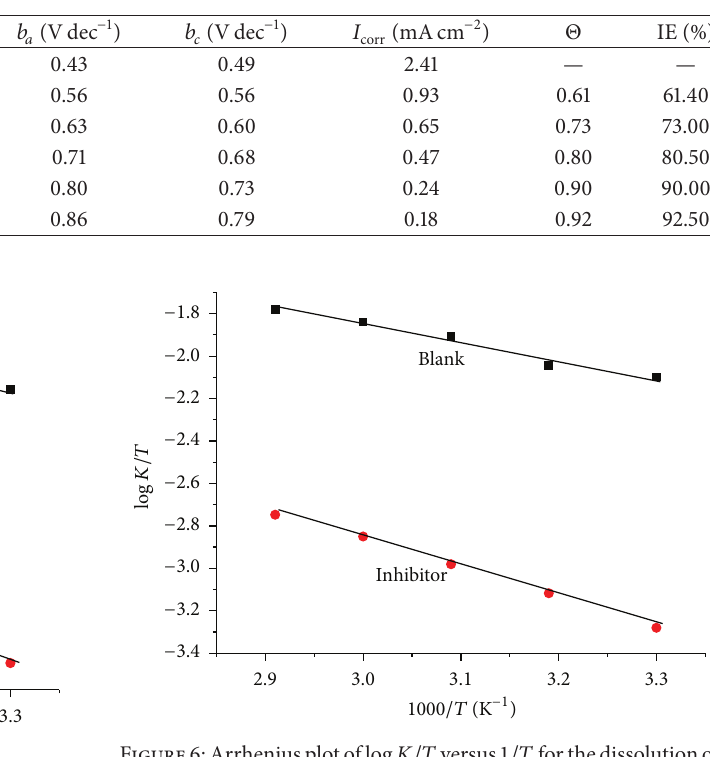
Figure 4: Potentiodynamic polarization curves of zinc electrode in 1.0M HCl solutions containing different concentrations of Marjoram extract at 30 ∘ C. (1) 0.00 ppm, (2) 100ppm, (3) 200 ppm, (4) 300 ppm, (5) 400 ppm, (6) 500 ppm. Table 3: Electrochemical parameters for zinc in absence and presence of different concentrations of Marjoram extract in 1.0M HCl solution at 30 ∘ C obtained from Tafel polarization curves.